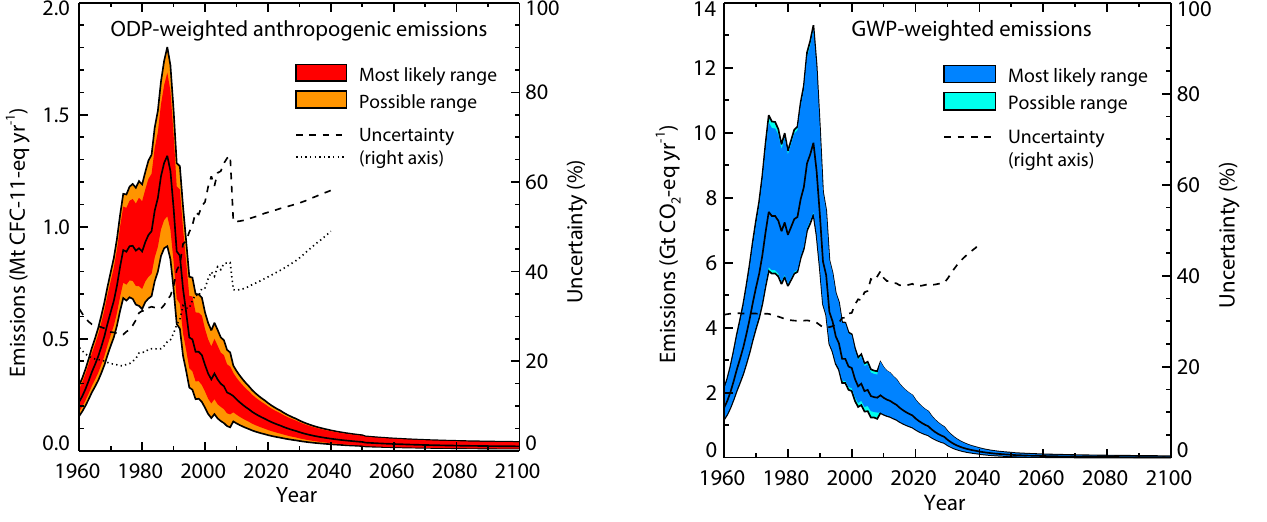
Fig. 10. GWP-weighted anthropogenic emissions from 1960 to 2100 using the lifetimes from SPARC (2013) and with uncertain- ties applied to all parameters. Shown are the median values and 95% confidence interval based on the possible (light blue) and most likely (dark blue) uncertainty ranges in lifetimes. The relative un- certainties (95% confidence interval) are also shown as percentages (dashed line) until 2040, when the emissions become very small. The contribution from natural emissions of CH 3 Br and CH 3 Cl is